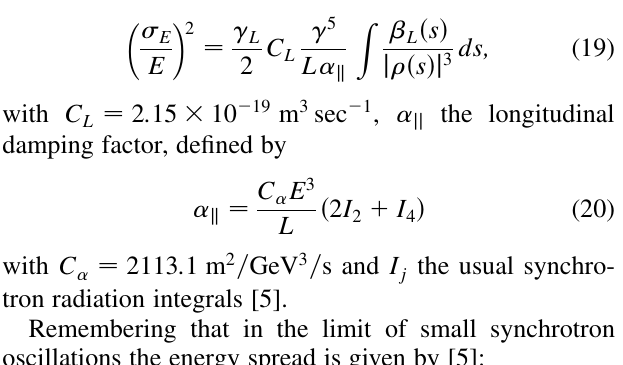
(cid:3) s (cid:4) along the ring in case B, for four 1 (0.001, 001, 0.02, 0.03, from darker to c (cid:3) s (cid:4) behavior in the ring 1 (0.001, 0.01, 0.02, 0.03—the c